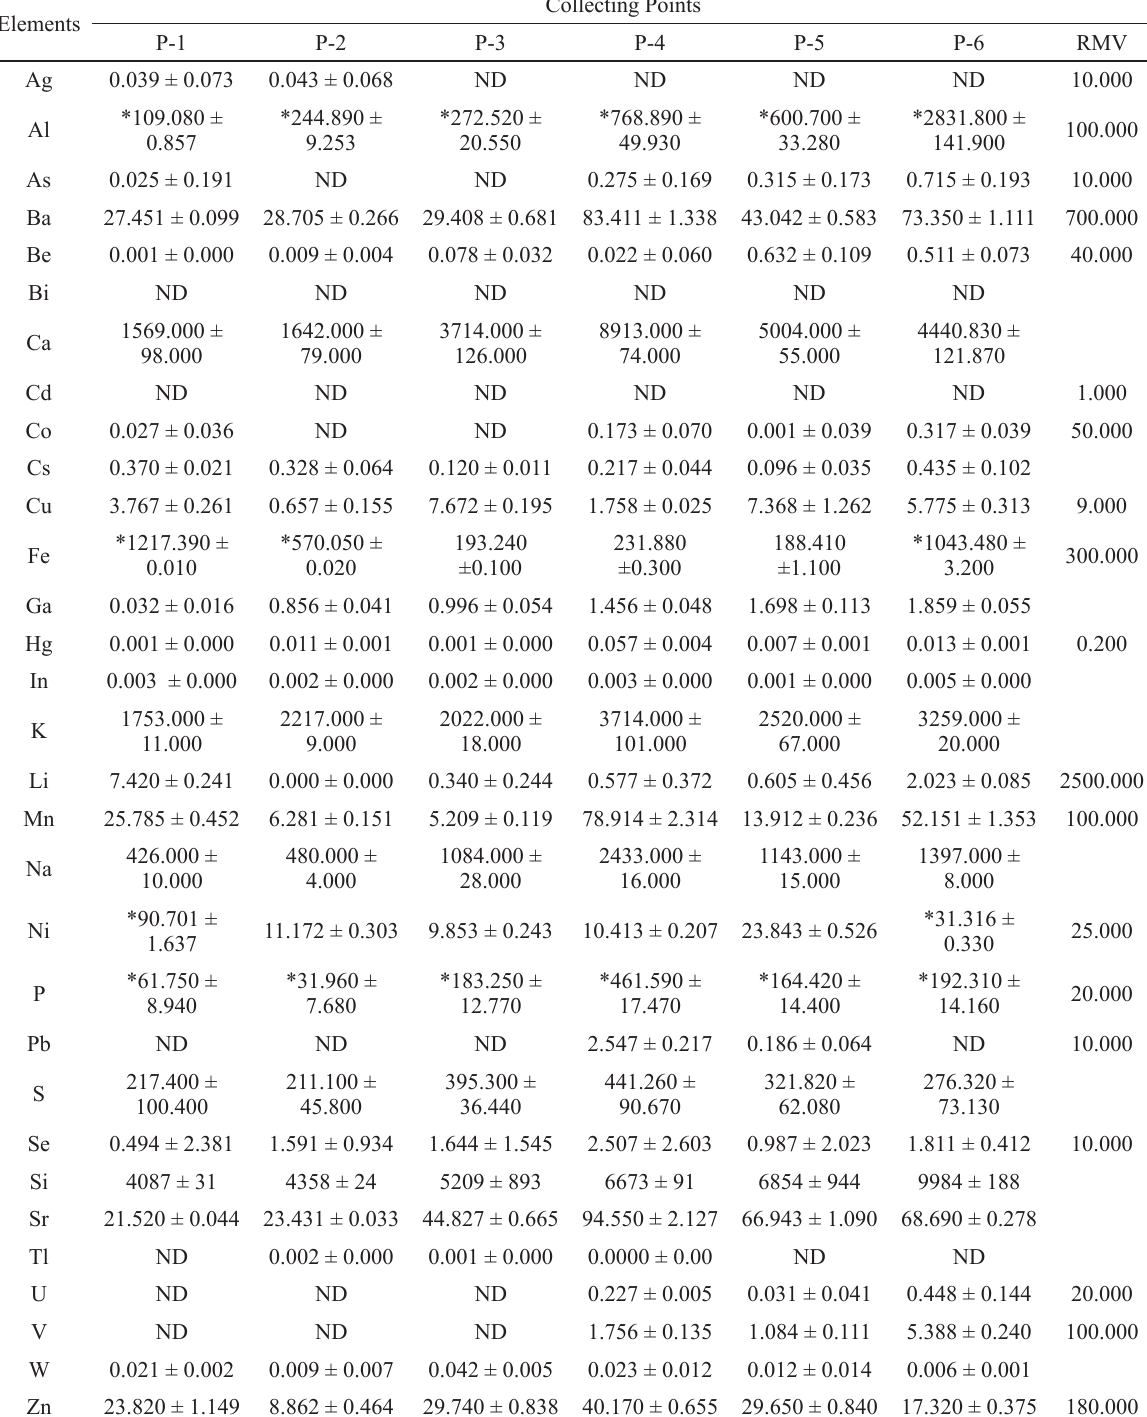
Mean values of trace elements in water samples during the rainy season (sample concentration ± standard deviation in